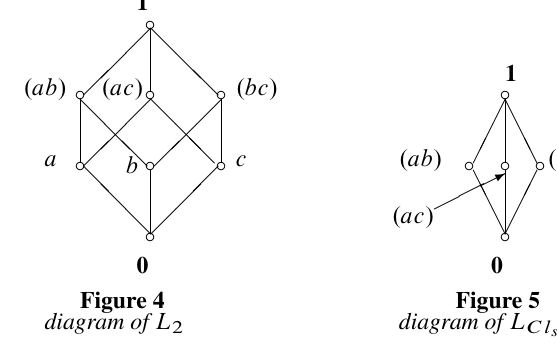
Figure 4 diagram of L 2